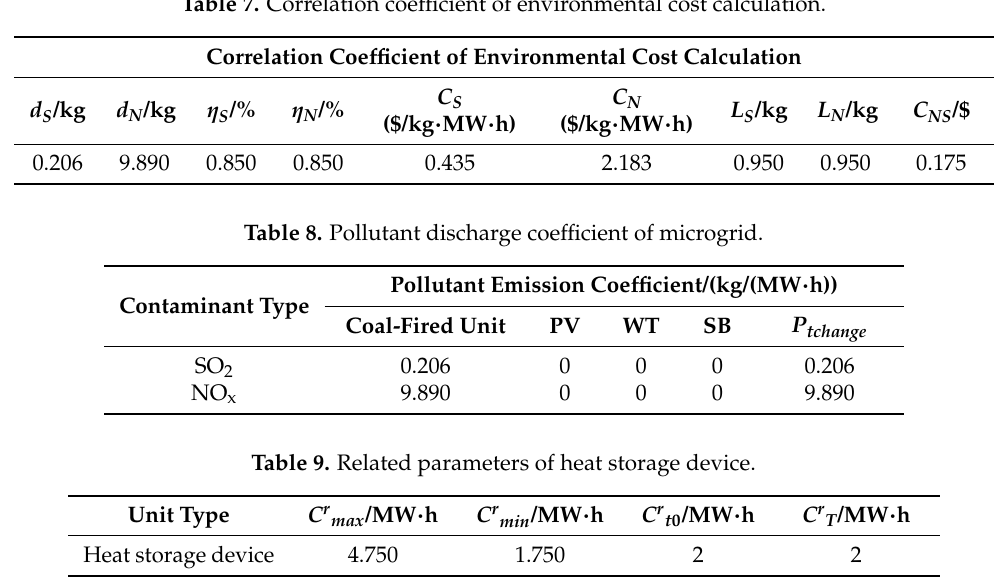
Table 7. Correlation coefficient of environmental cost calculation.